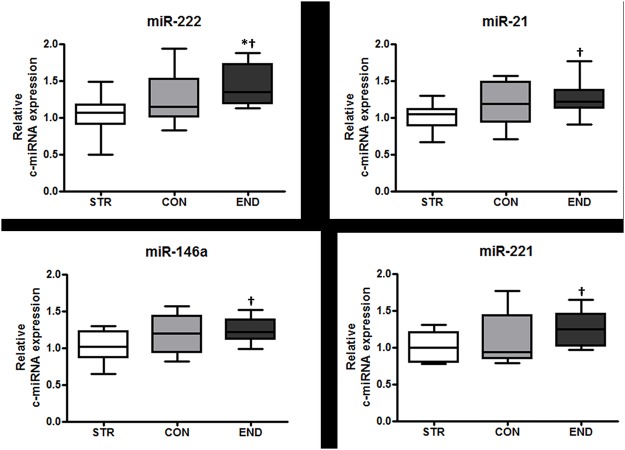
Relative expression levels of miR-222 (A), -21 (B), -146a (C), and -221 (D) in STR, CON and END.Box plots depict the range (upper and lower whiskers), median (centre line) and interquartile range (edge of boxes). * significantly different between all groups (One way ANOVA; p < 0.05); † significantly different from STR (t-test; p < 0.05).